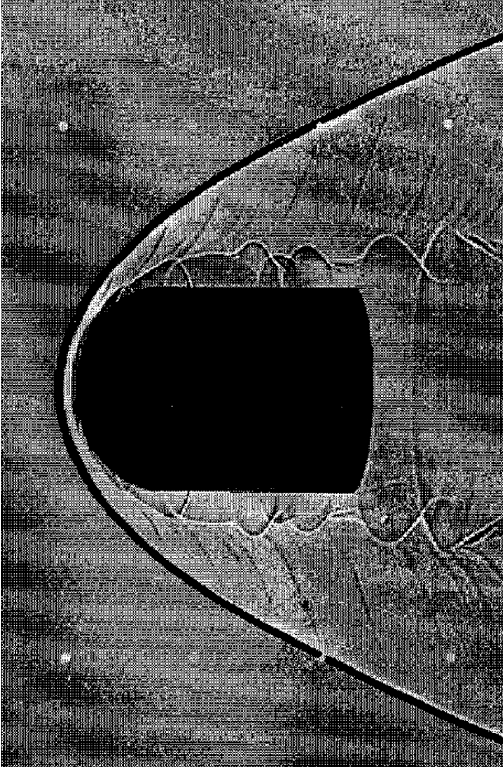
Figure 1. Experimental shadowgraph of periodical oscillation observed taken at 12° angle from perpendicular direction for M = 4.48 in Lehr’s experiment [7].